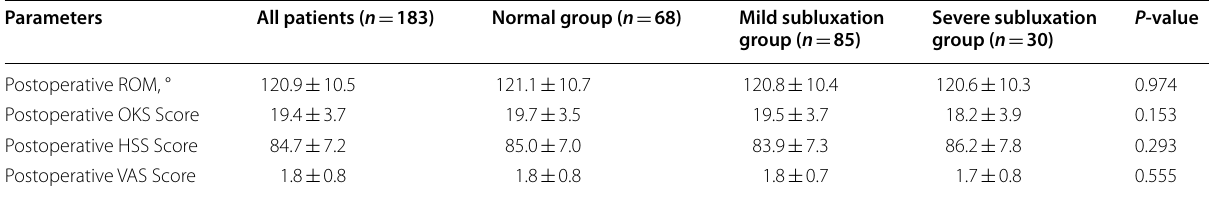
Table 2 Postoperative clinical results in patient subluxation subgroups Parameters